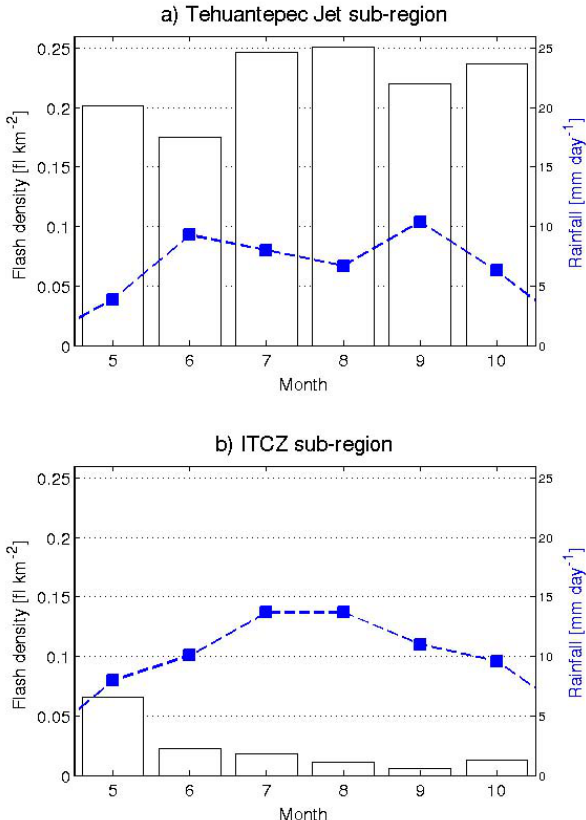
Fig. 9. Monthly variability of lightning flash density (bars) and pre- cipitation (blue line) over the (a) Tehuantepec Jet and (b) ITCZ sub- regions during rainy